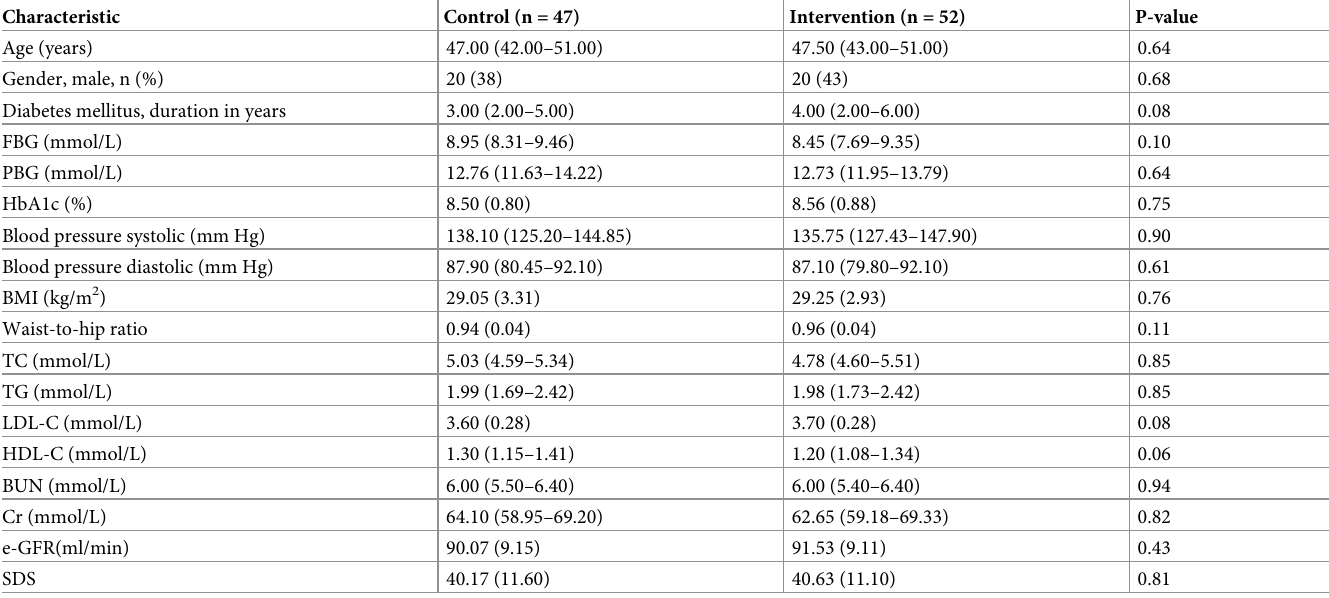
Table 1. Baseline characteristics of the two